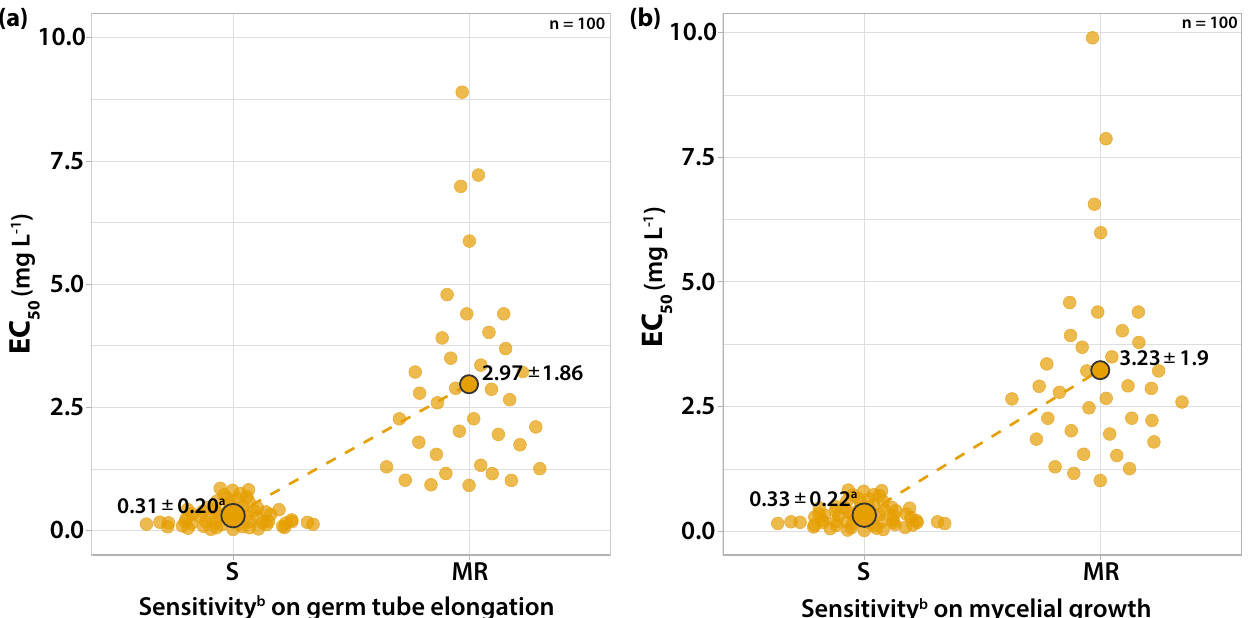
Figure 4. Frequency of sensitivity distribution for one hundred V. inaequalis isolates to dodine on ( a ) germ tube elongation and ( b ) mycelial growth. The mean EC 50 values for the moderately resistant population of V. inaequalis were significantly higher ( p < 0.05) than the mean EC 50 val- ues of the sensitive population on both tests according to the Welch’s t -test. a Average values of sensitivity groups ± standard deviation; circle size reflects the population number. b Sensitivity groups: S, sensitive; MR, moderately